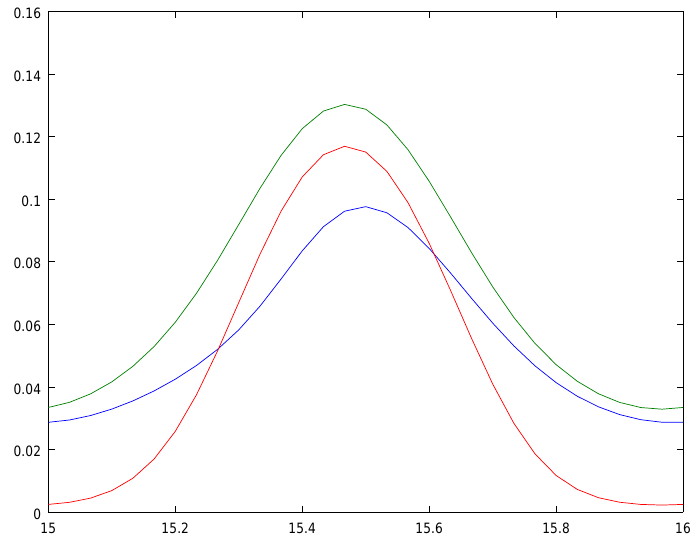
Figure 8. Example 2. E ( t 0 , p ( t 0 ) | A ) (blue) , E ( t 0 , p ( t 0 ) | K ) (green), E ( t 0 , p ( t 0 ) | S )